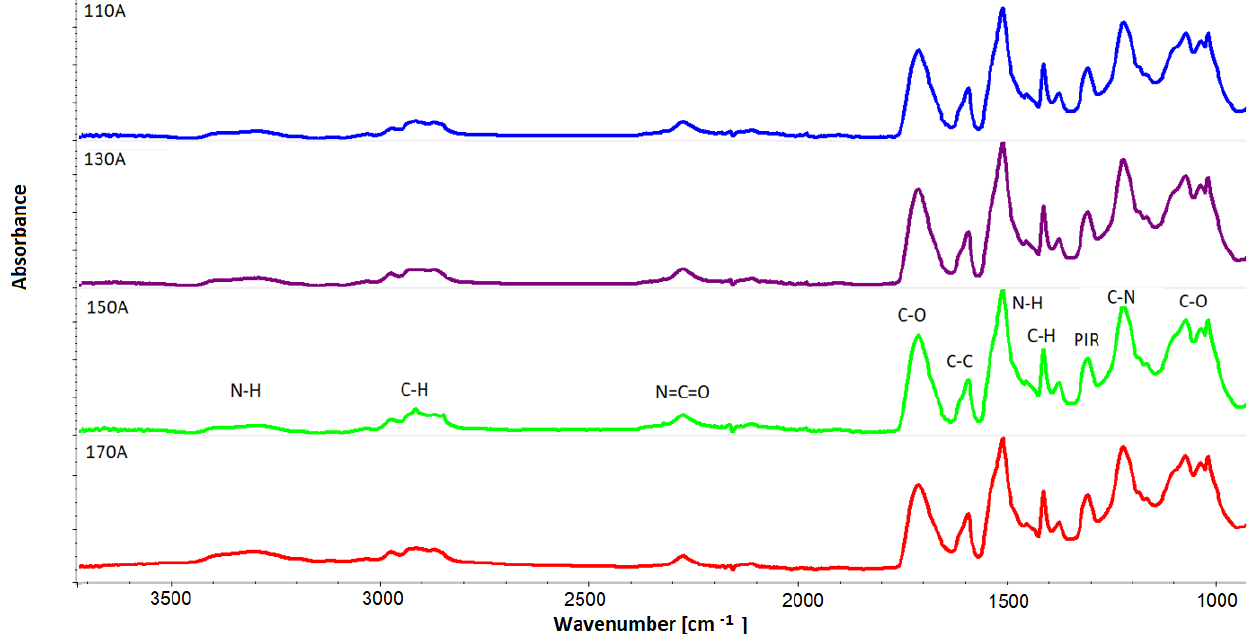
Figure 14. FTIR spectra of samples taken from the outer part of the foam blocks (A). Quantitatively, changes in multiple band components of carbonyl groups (Figure 15) were analyzed, and the procedure for multiple band analysis is described in the paper [24]. The multiplet bands were scaled relative to the 1593 cm − 1 band from the C-C groups in the aromatic groups. Based on the multiple band component analysis results, the proportion of urea groupings (part of urea groups) and of urethane groupings (part of urethane groups) in the hard phase of the tested foams was calculated. The index of hydrogen bonds (IH) connecting the rigid segments in the tested foams was also calculated.